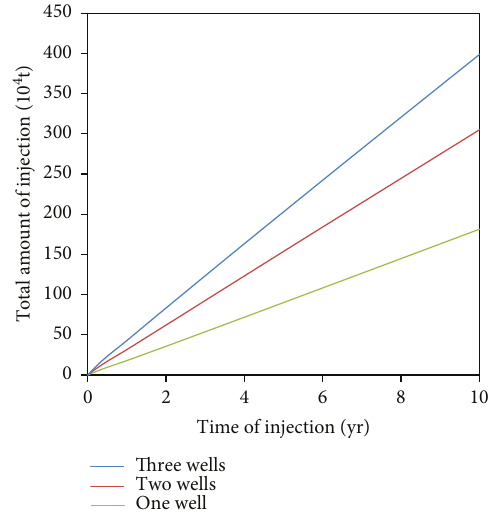
Figure 23: Total amount of CO